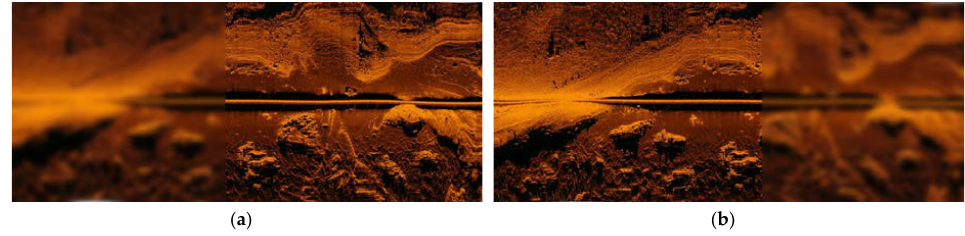
Figure 5. Oil pipelines. ( a ) Left region blurred. ( b ) Right region blurred.